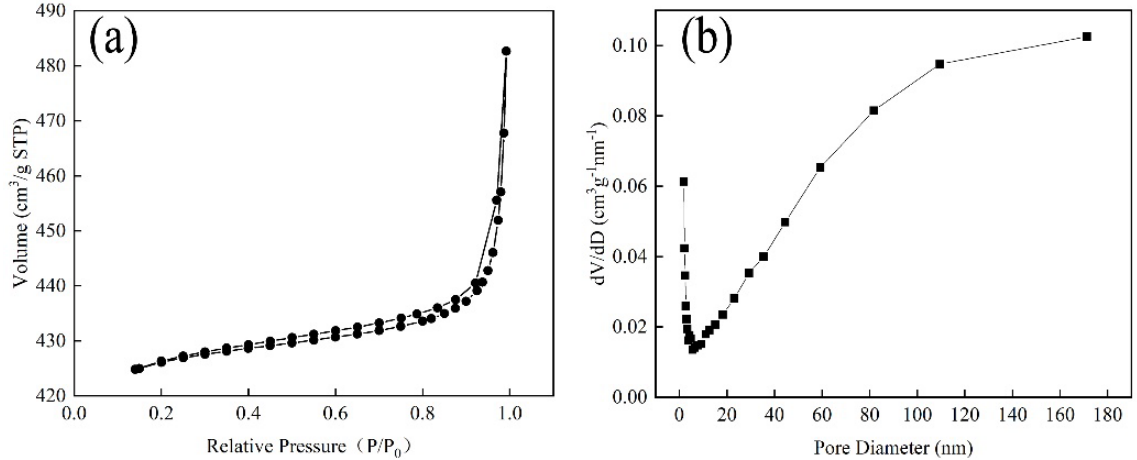
Figure 1. ( a ) Adsorption/desorption curves of ZIF-8 and ( b ) pore-size distribution of ZIF-8.